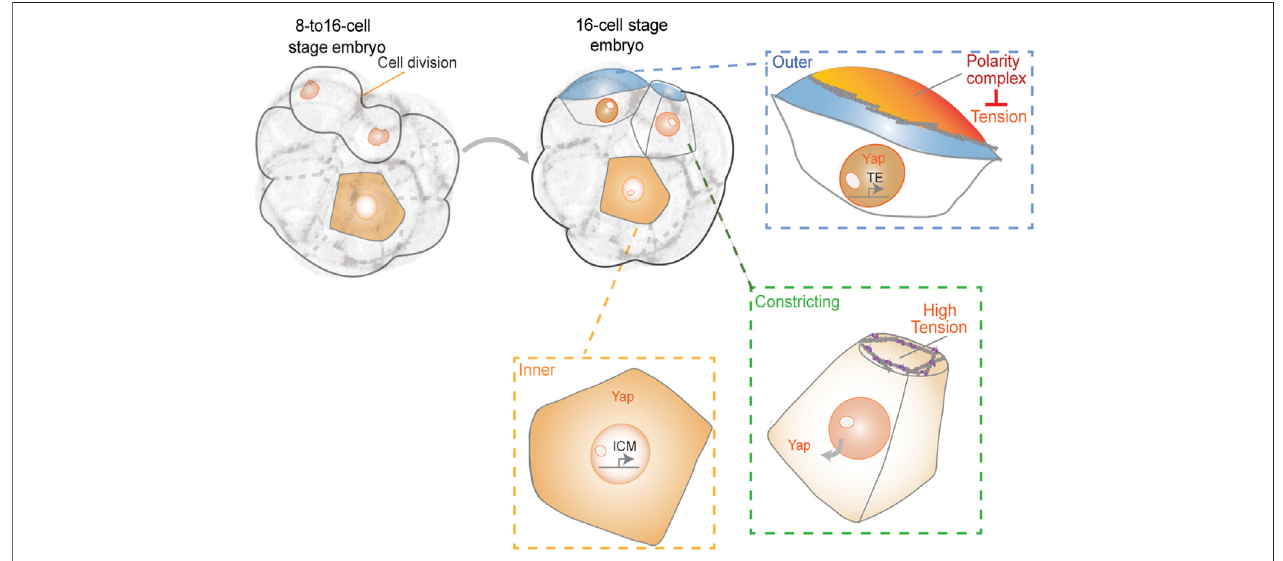
FIGURE2| Firstlineagesegregationduring8-to16-celltransition.Theresultingdaughtercellsshowdifferencesinpolarity,contractility,andexposedsurfacearea. Together, these properties may control cell fate acquisition, resulting in appropriate partitioning of ICM and TE cells during patterning of the blastocyst.